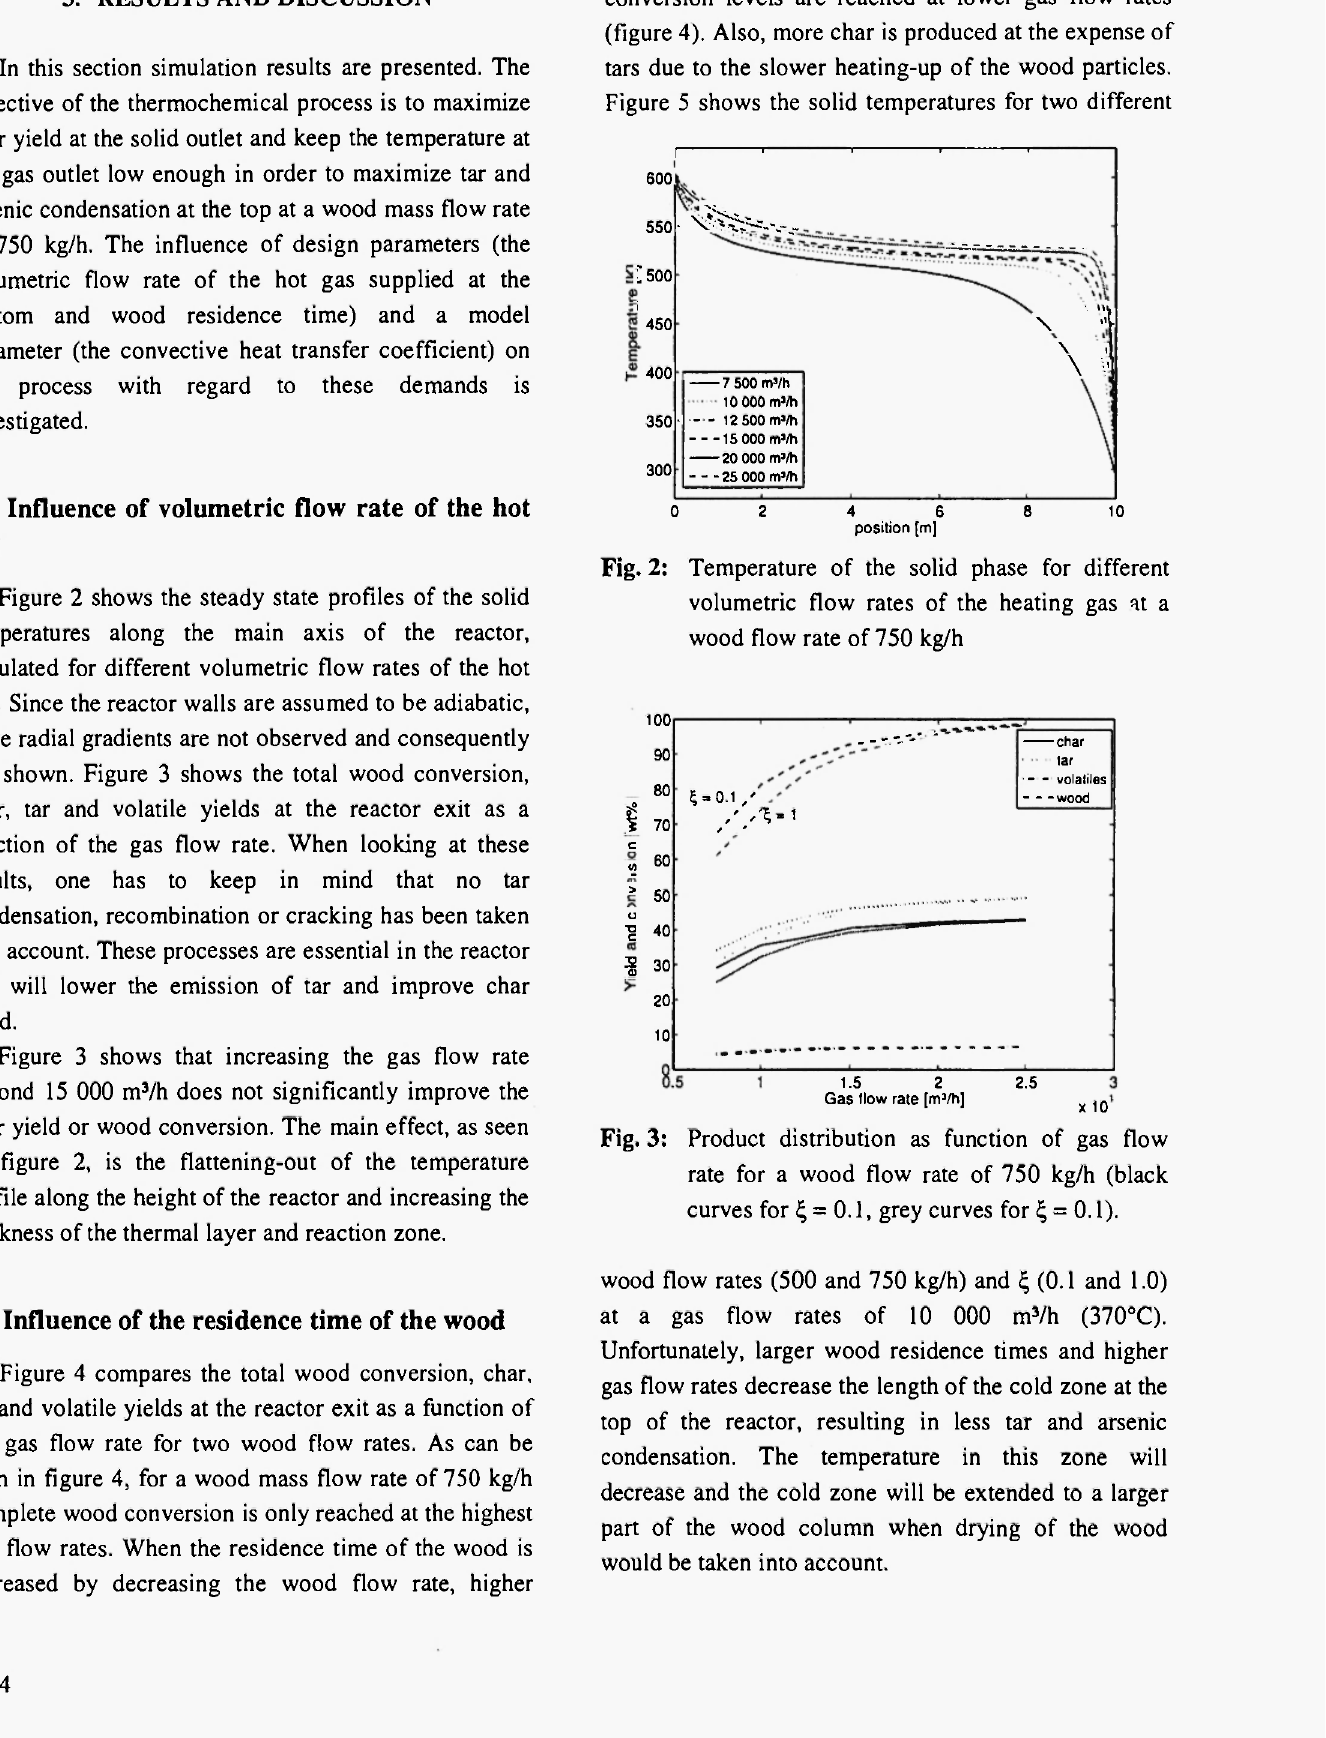
Fig. 2: Temperature of the solid phase for different volumetric flow rates of the heating gas at a wood flow rate of 750 kg/h